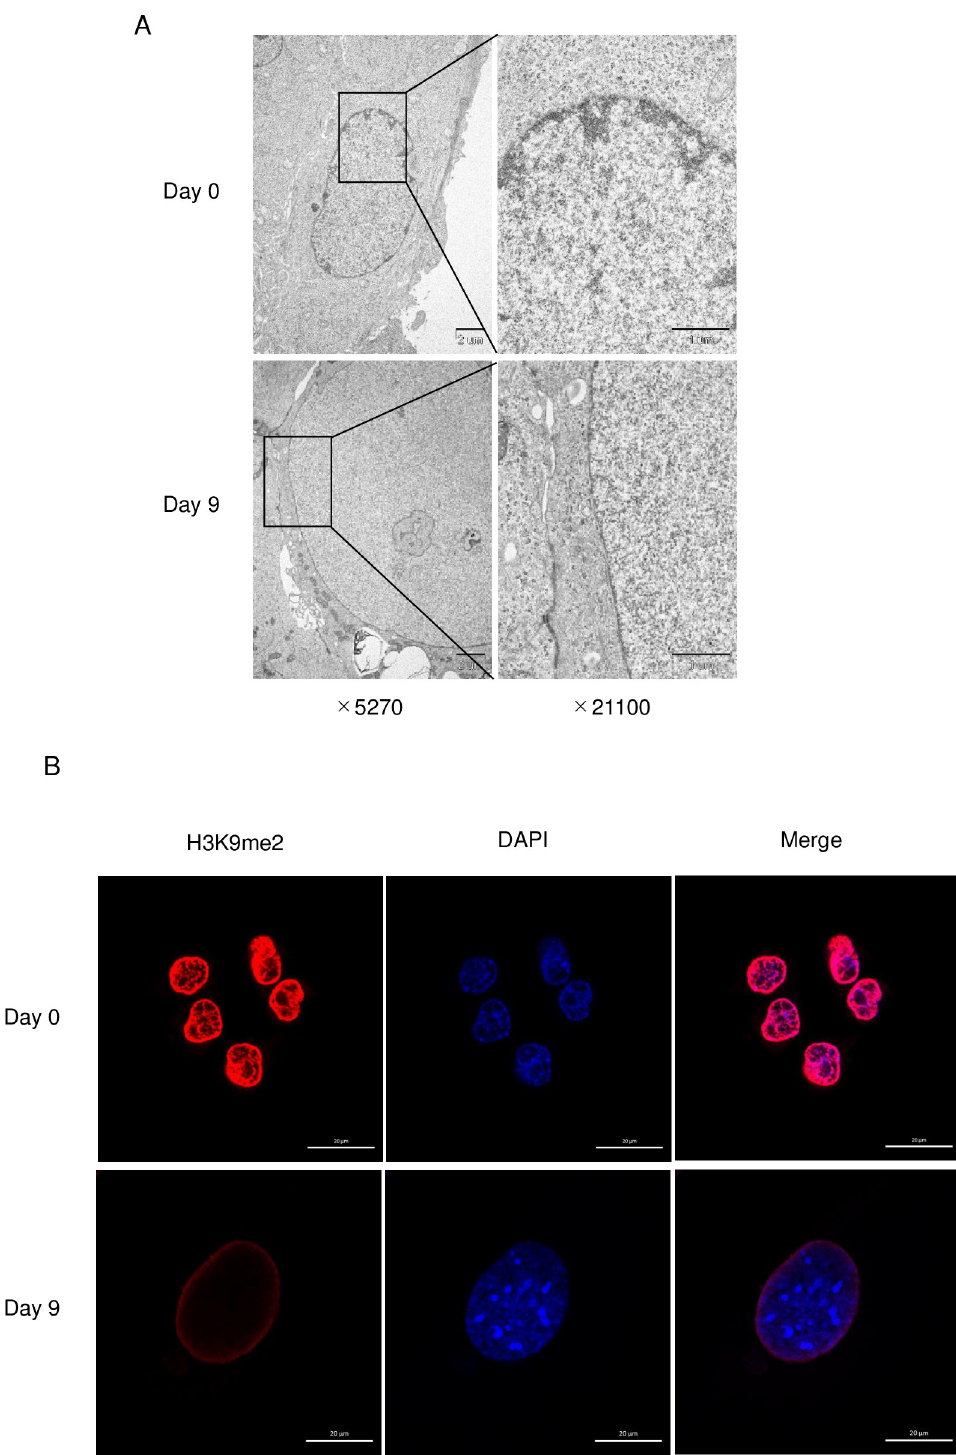
Fig 2. Nuclear structures of TSCs and TGCs. (A) Electron micrographs of TSC (Day 0) and TGC (Day 9) nuclei. (B) Localization of H3K9me2 in TSC (Day 0) (n = 341) and TGC (Day 9) (n = 226). Bars mean 20 μ m.